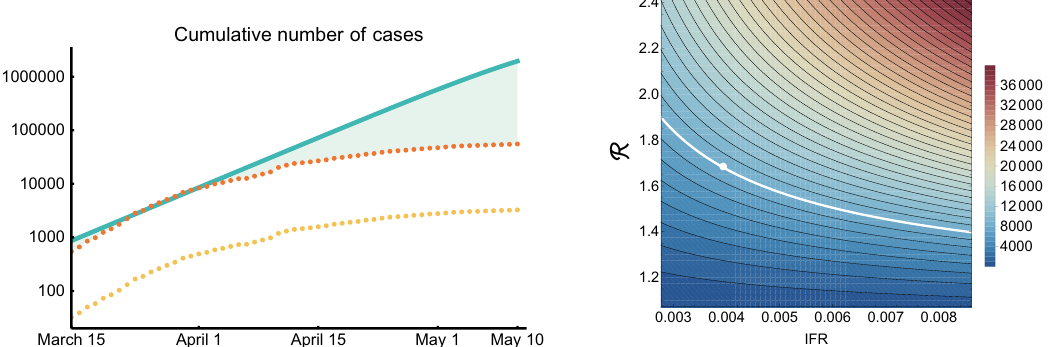
Figure 14. Left: the impact of control measures on the epidemic trajectory. Yellow dots are cumulative numbers of reported cases, orange dots are corrected data by underascertainment rate, solid curve is simulated cumulative numbers with R = 2.2 and the absence of measures. Right: Sensitivity of the peak ICU demand to transmissibility and severity of COVID-19. The top right corner is similar to the worst case scenario of [41]. The white dot is our most pessimistic scenario (weak